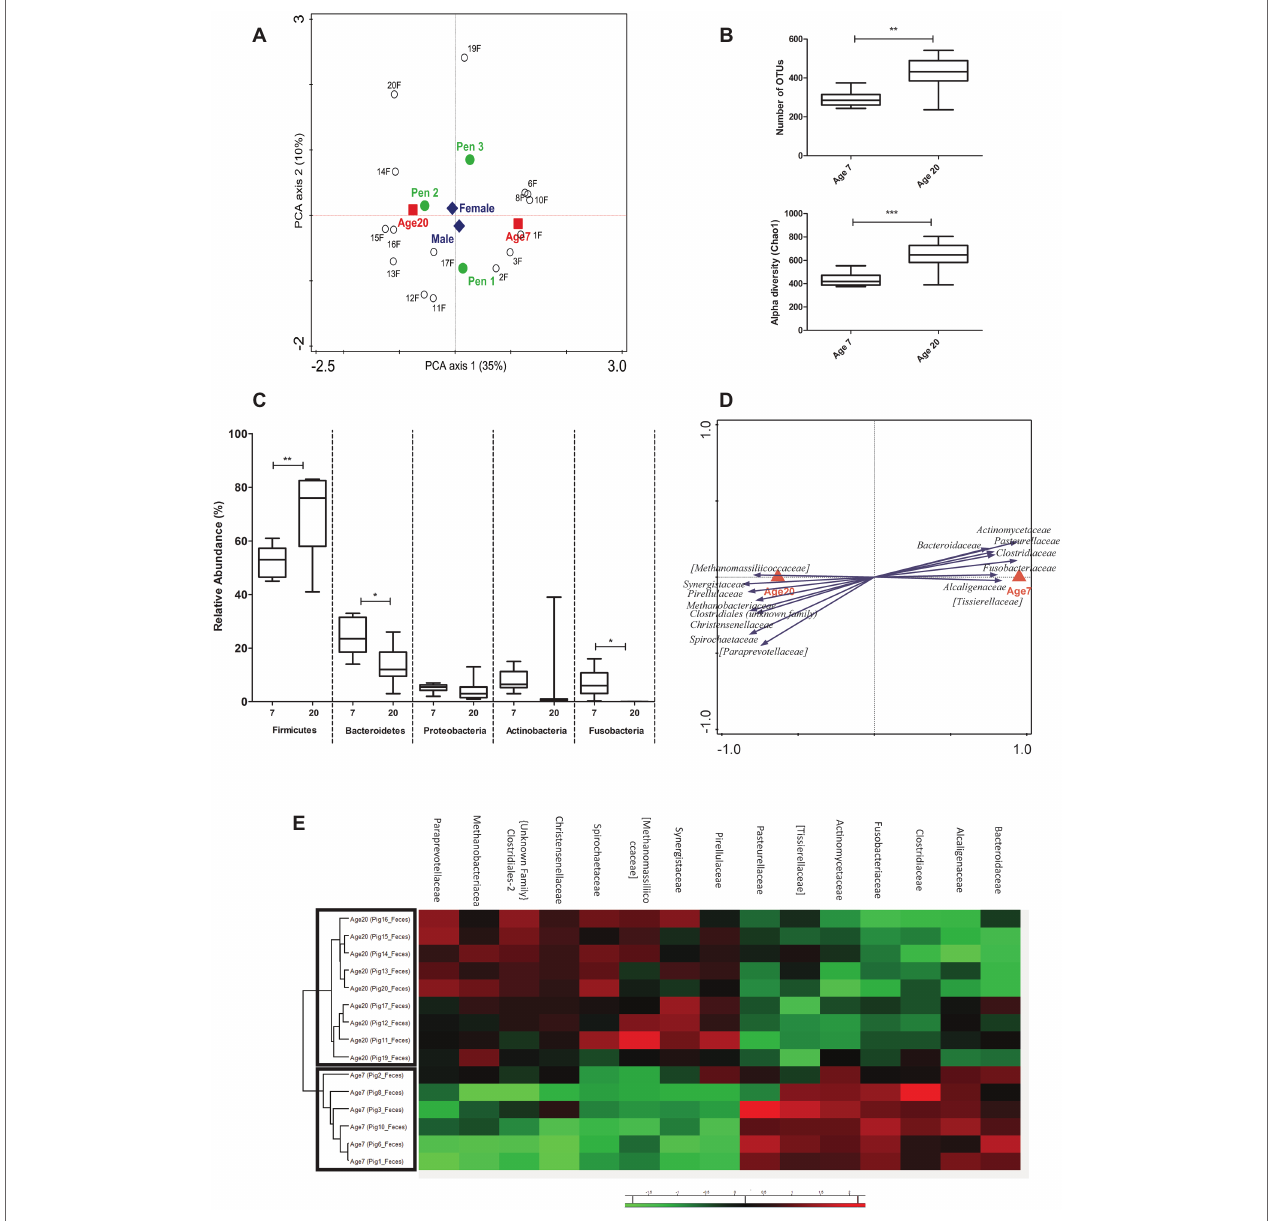
FIGURE 2 | Microbial composition and explanatory variables of fecal samples. (A) Principal Component Analysis (PCA) plot showing variation in terms of explanatory variables in the data. Testing single variables by Weighted UniFrac PERMANOVA supports clear separation by age ( p < 0.001) and pen ( p = 0.013) but not by gender ( p = 0.948). (B) Alpha diversity (Number of OTUs and Chao1 bias corrected) showing increased diversity at 20 compared to 7 days of age. (C) Relative abundance of five phyla (with highest relative abundance) at two ages in fecal samples (Mann Whitney test). (D) Partial redundancy analysis (pRDA) for the explanatory variable age (corrected for pen) at family level (RD1 = 40.23% and RD2 = 11.36%). (E) Heat map showing relative abundance of 15 most discriminative bacterial families for age. * p < 0.05, ** p < 0.01, *** p <